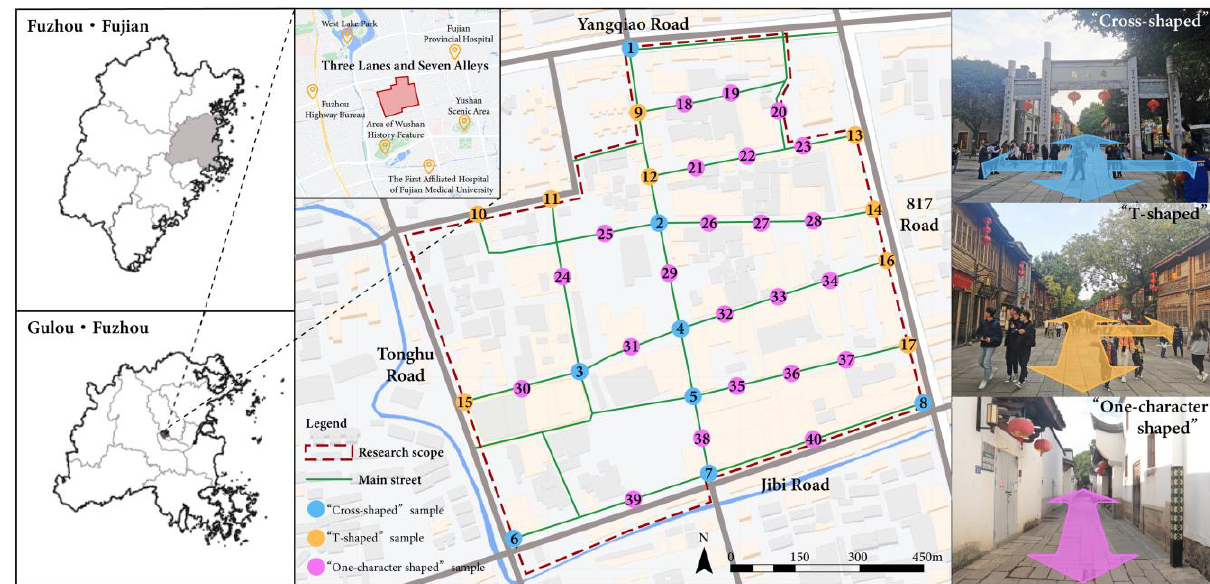
Figure 1. The geographical location of the Three Lanes and Seven Alleys and the specific location of the study sample site. The blue dots represent the “Cross-shaped” spatial samples, the yellow dots represent the “T-shaped” spatial samples, and the purple dots represent the “One-character shaped” spatial samples .